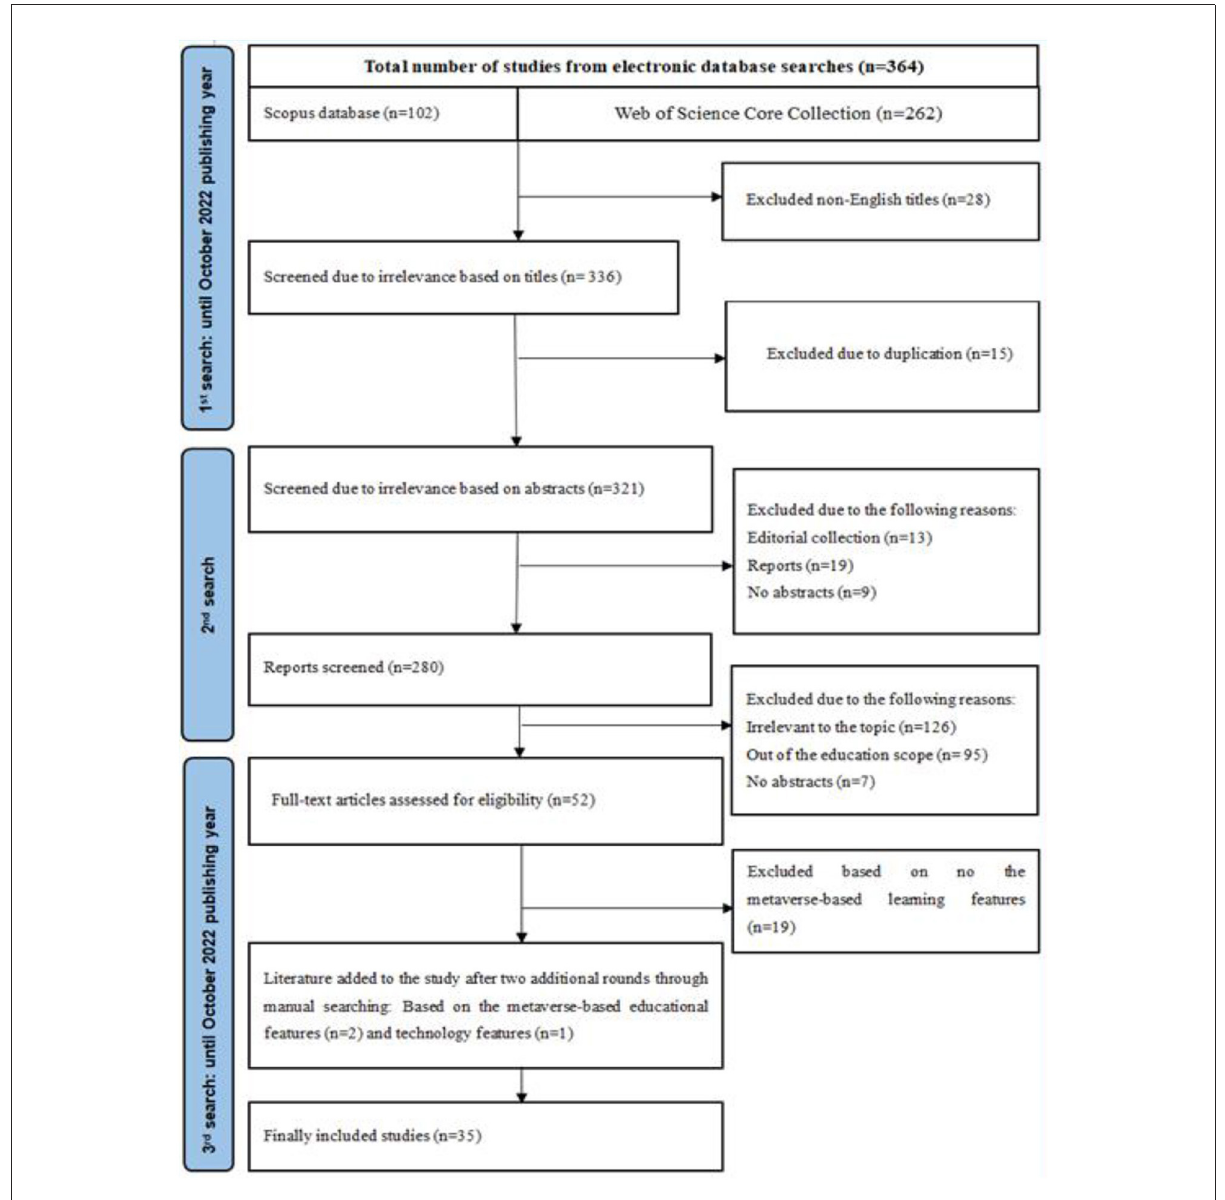
FIGURE2 A flowchart of the literature inclusion and exclusion based on the PRISMA protocol.